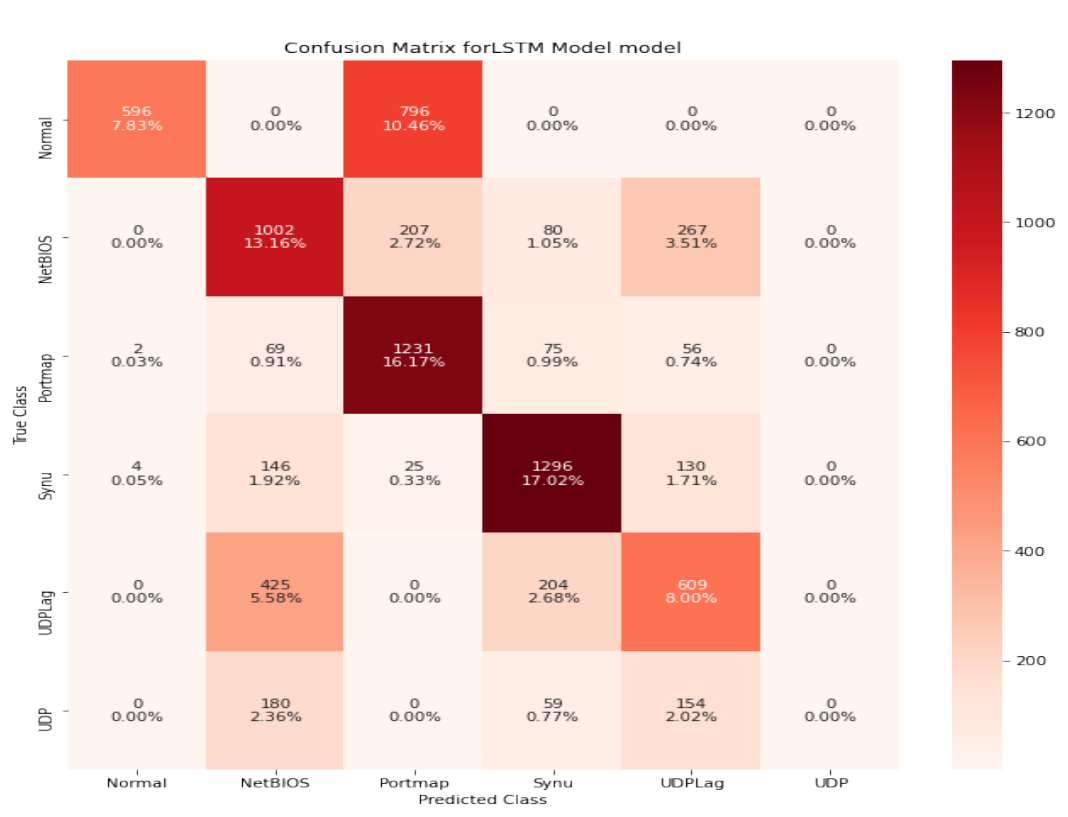
Figure 7. LSTM model performance for detection attacks on Agriculture 4.0. ( a ) Model accuracy; ( b ) model loss.